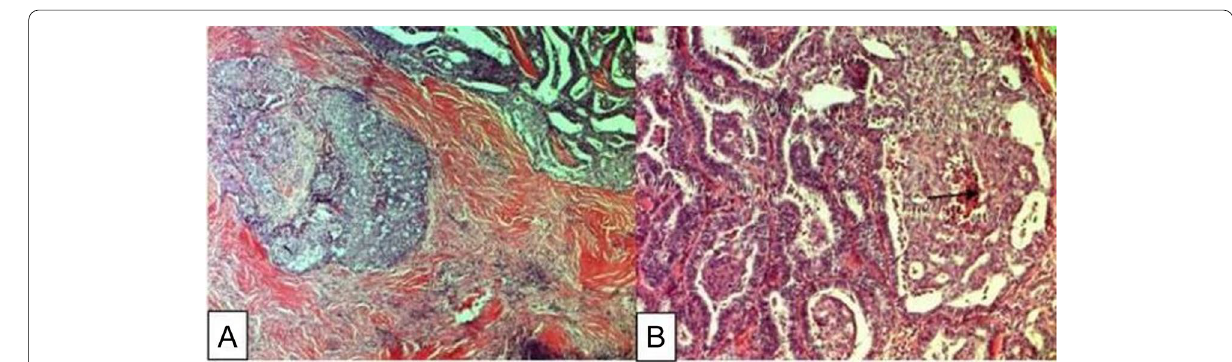
Fig. 2 High magnification of tumor pattern. A Tumor exhibit papillary pattern with solid and cribriform areas (HE metaplasia (indicated by an arrow) within cribriform and papillary structures (HE